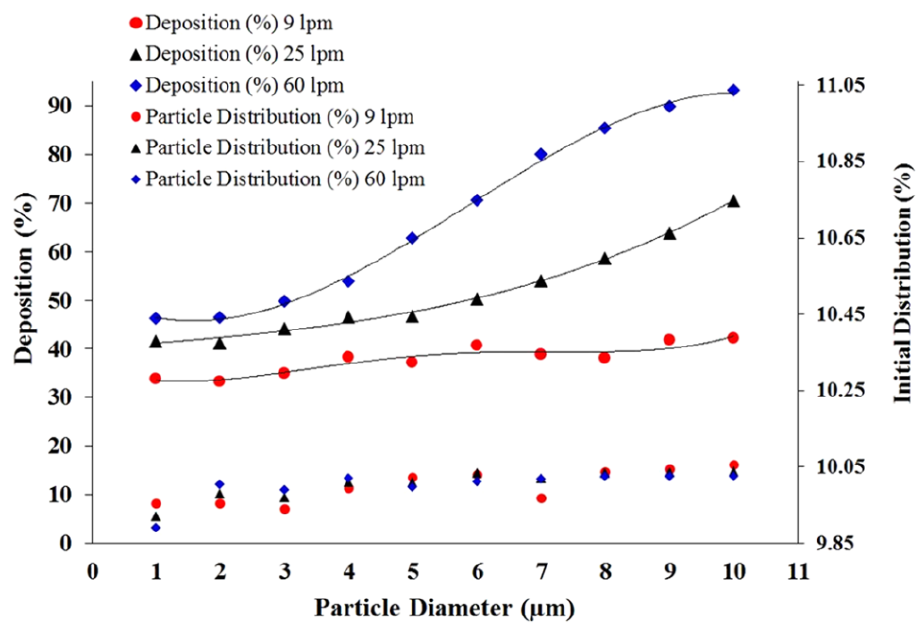
Figure 9. Polydisperse particle initial distribution and deposition efficiency at different flow rates [183].